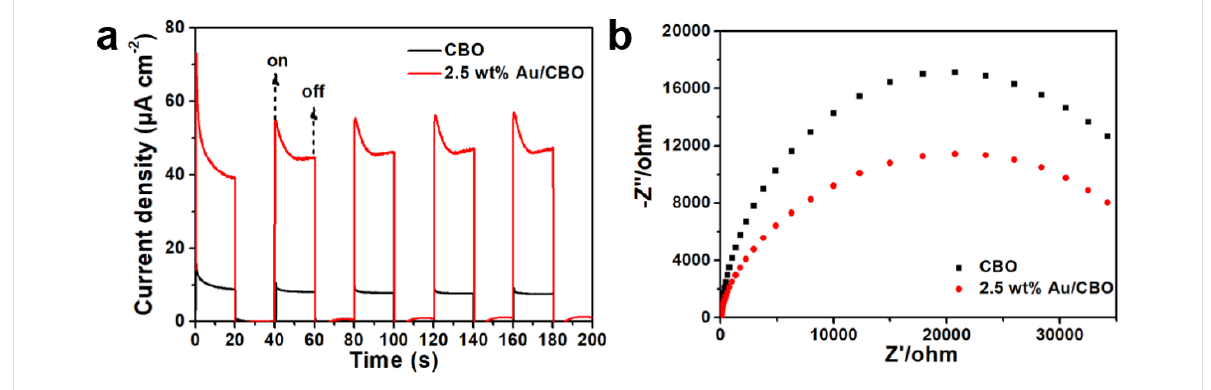
Figure 7: (a) Photocurrent response and (b) EIS spectra of bare CBO and 2.5 wt % Au/CBO composite under visible-light irradiation.